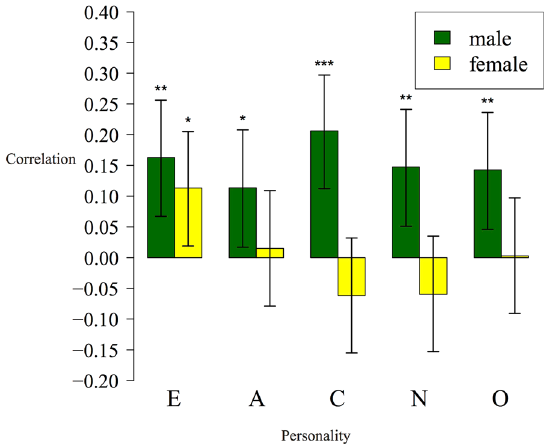
Figure 3. Pearson correlations between surveyed personality scores and the predicted ones under the LOO procedure. A linear model is used to predict each personality score based on 20PC facial data. p-values and significances of correlation tests are labeled above the bar as numbers and asterisks respectively. * p <= 0.05; ** p <= 0.01; *** p <=